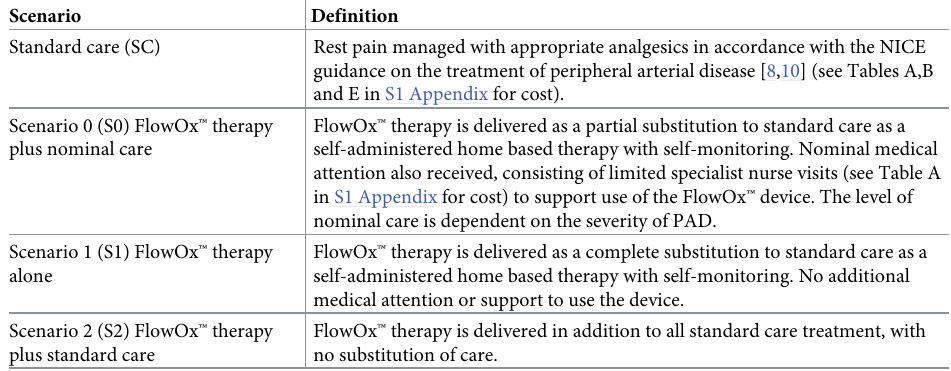
Table 1. Intervention scenario definitions for Markov model.